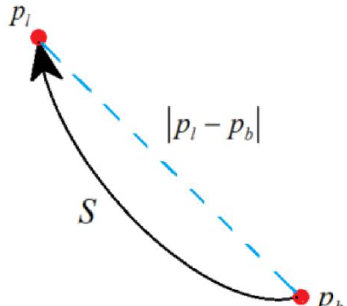
Figure 6. The relationship between symbols.